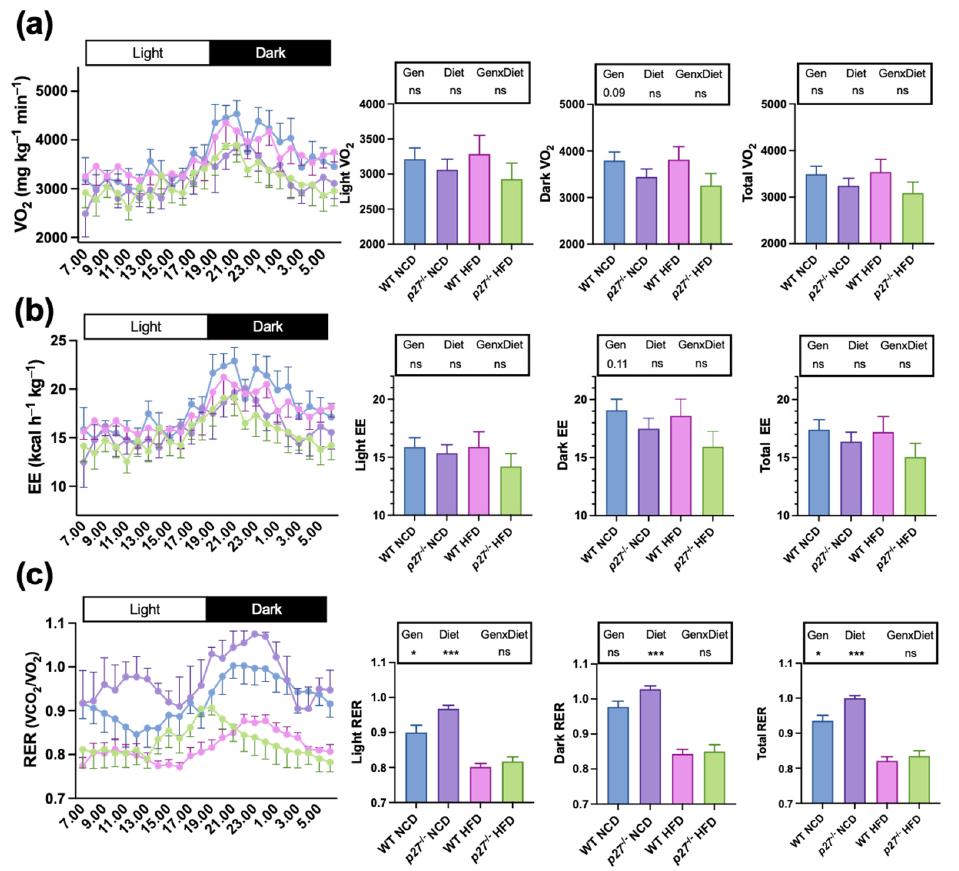
Figure 2. Mice lacking p27 have increased respiratory exchange ratio (RER). ( a ) Oxygen consump- tion (VO 2 ). ( b ) Energy expenditure. ( c ) Respiratory exchange ratio (RER) measured by indirect calorimetry in WT and p27 -/- mice fed with NCD or HFD for 10 weeks. Data are expressed as mean ± SEM ( n = 4–7). Legend above subfigures shows the result of the two-way ANOVA analysis; * p < 0.05 , *** p < 0.001, ns: non-significant. Gen, genotype; GenxDiet, interaction between genotype and diet.